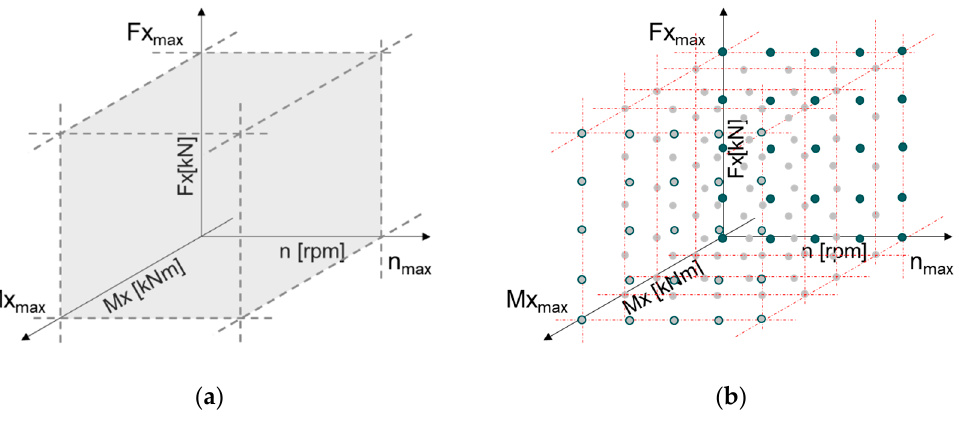
Figure 1. Illustration of an example of: (a) design space for a 3-factor experiment (b) the same design space discretized into five factor levels per factor.